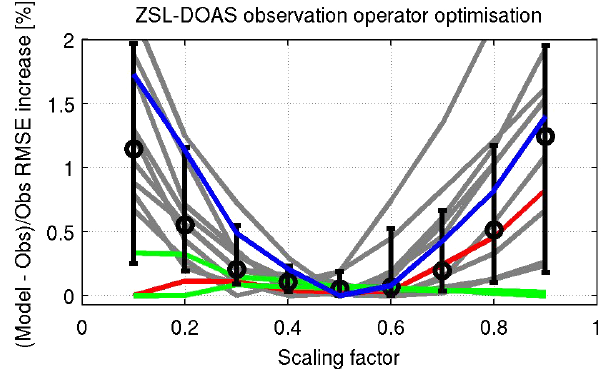
Figure 7. Increase in comparison spread (w.r.t. the optimum) be- tween simulated and observed SAOZ measurements as a function of observation operator scaling factor for all NDACC stations (grey and coloured lines). The median curve with 0.16–0.84 interper- centile error bars is shown with black markers. The optimal ob- servation operator size appears to be about half the currently as- sumed size. The red curve corresponds to the results at Hohen- peißenberg, and the green curves, showing no clear minimum, cor- respond to tropical stations (Bauru and St. Denis). At tropical lati- tudes, the TOC variability is low at the scale of a few hundred km and hence the exact shape of the observation operator is not of great importance. The blue curve represents the optimization at Dumont d’Urville, i.e. the current case study.